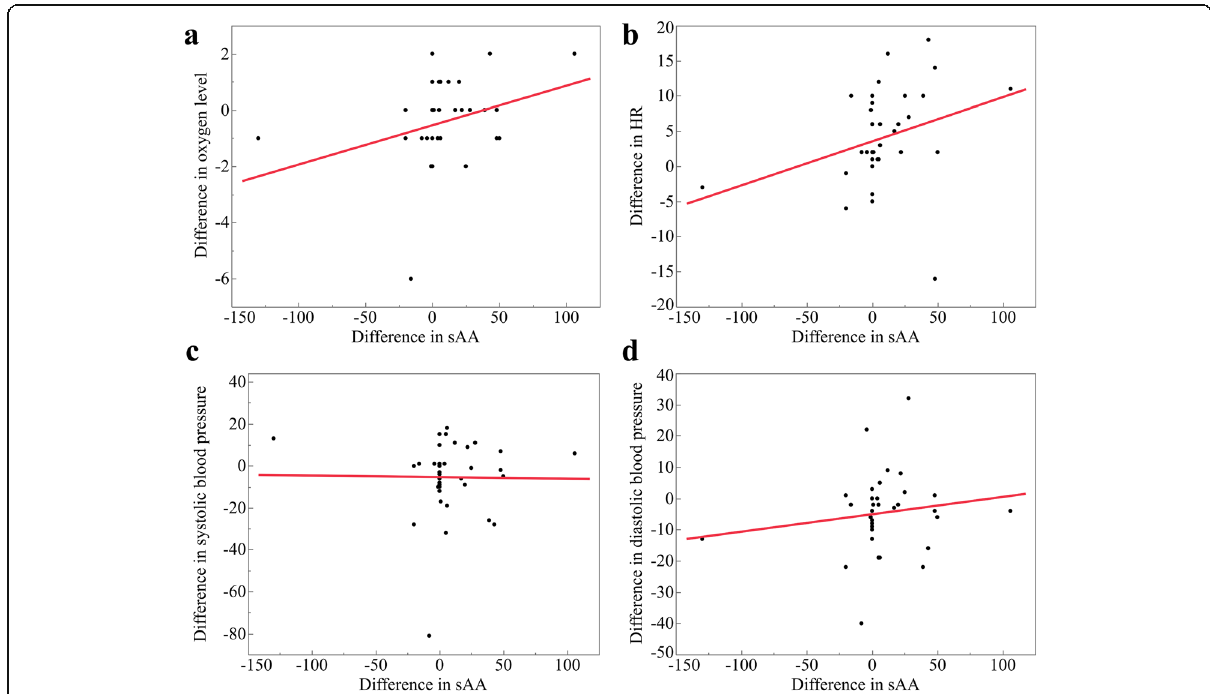
Fig. 4 Scatter plot showing the correlation between the difference of sAA and a oxygen level, b heart rate, c systolic blood pressure, and d diastolic blood pressure. A positive correlation presented between difference in sAA and a oxygen level and b heart rate ( p <0.05)